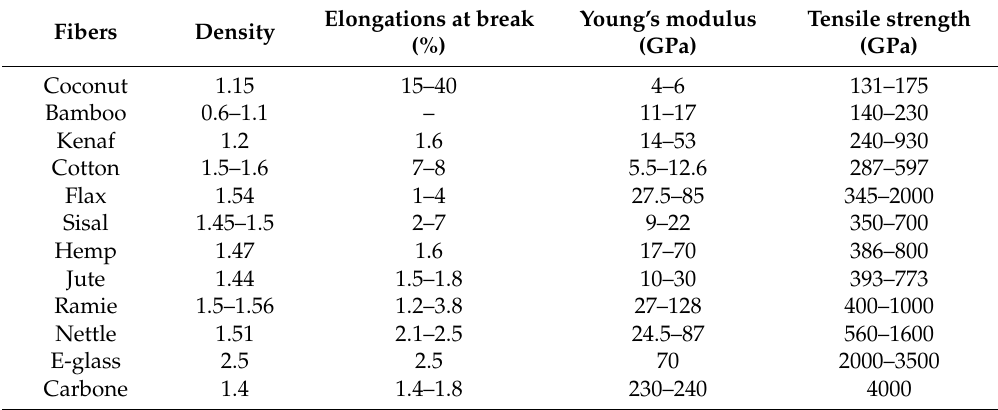
Table 1. The mechanical properties of plant fibers with an increasing order of tensile strength [8].